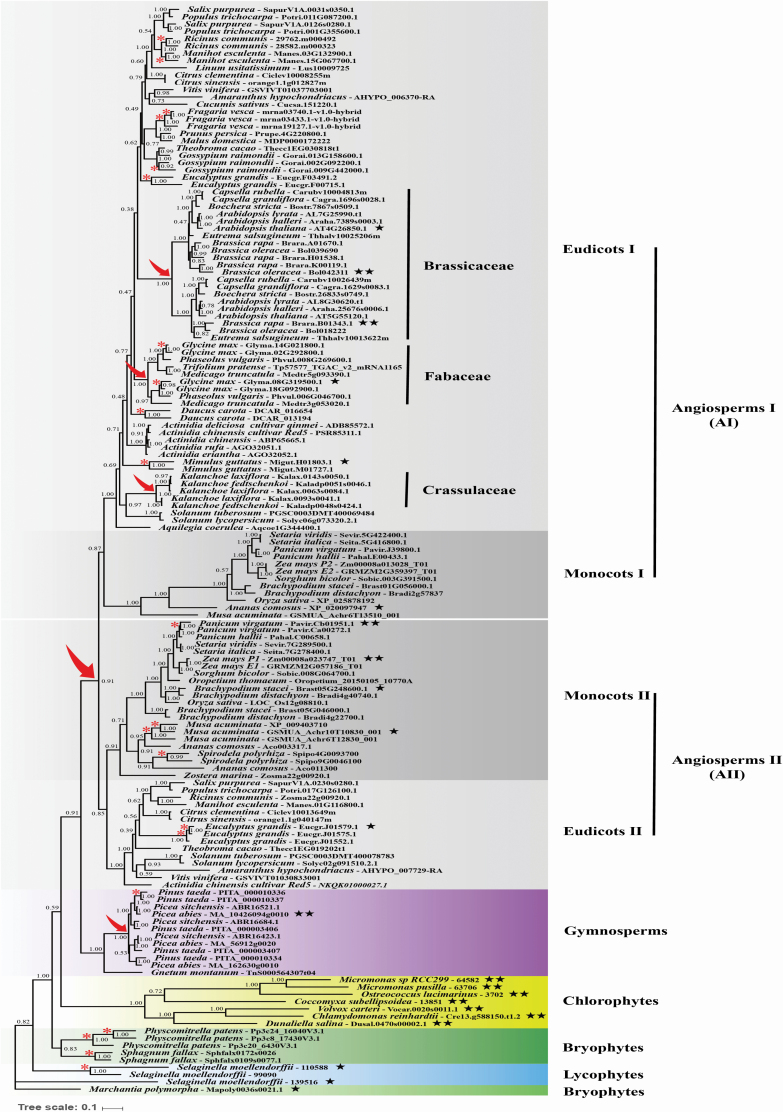
Phylogenetic analyses of plant GGP genes using the Bayesian method. The phylogenetic tree was constructed through the Bayesian method under the GTR+I+G model. Posterior probabilities are labelled near the nodes. The accession number of the GGP gene is listed after the name of the species. Red arrows indicate shared WGDs. Red asterisks (*) indicate lineage-specific WGDs. Black star (★) indicates the branch is identified under episodic diversifying selection by branch-site model. Double black stars (★★) indicate that the branch is still under positive selection after Bonferroni correction.